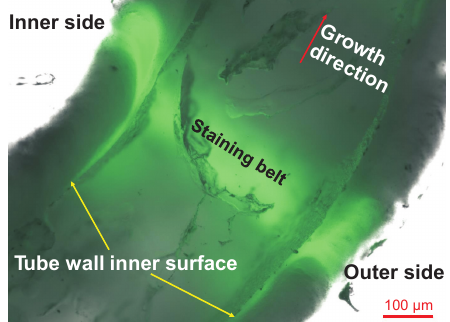
Figure 7. Fluorescent microscope image of S. spirorbis tube cross section with staining line showing green fluorescence. Sample from spring + CO 2 + T experiment. The green belt is the stained part of the shell that formed during the 3 days of calcein staining before the start of the experiment. Newly grown shell forms a lining along the inner tube wall surface (yellow arrows). Red arrow indicates the growth